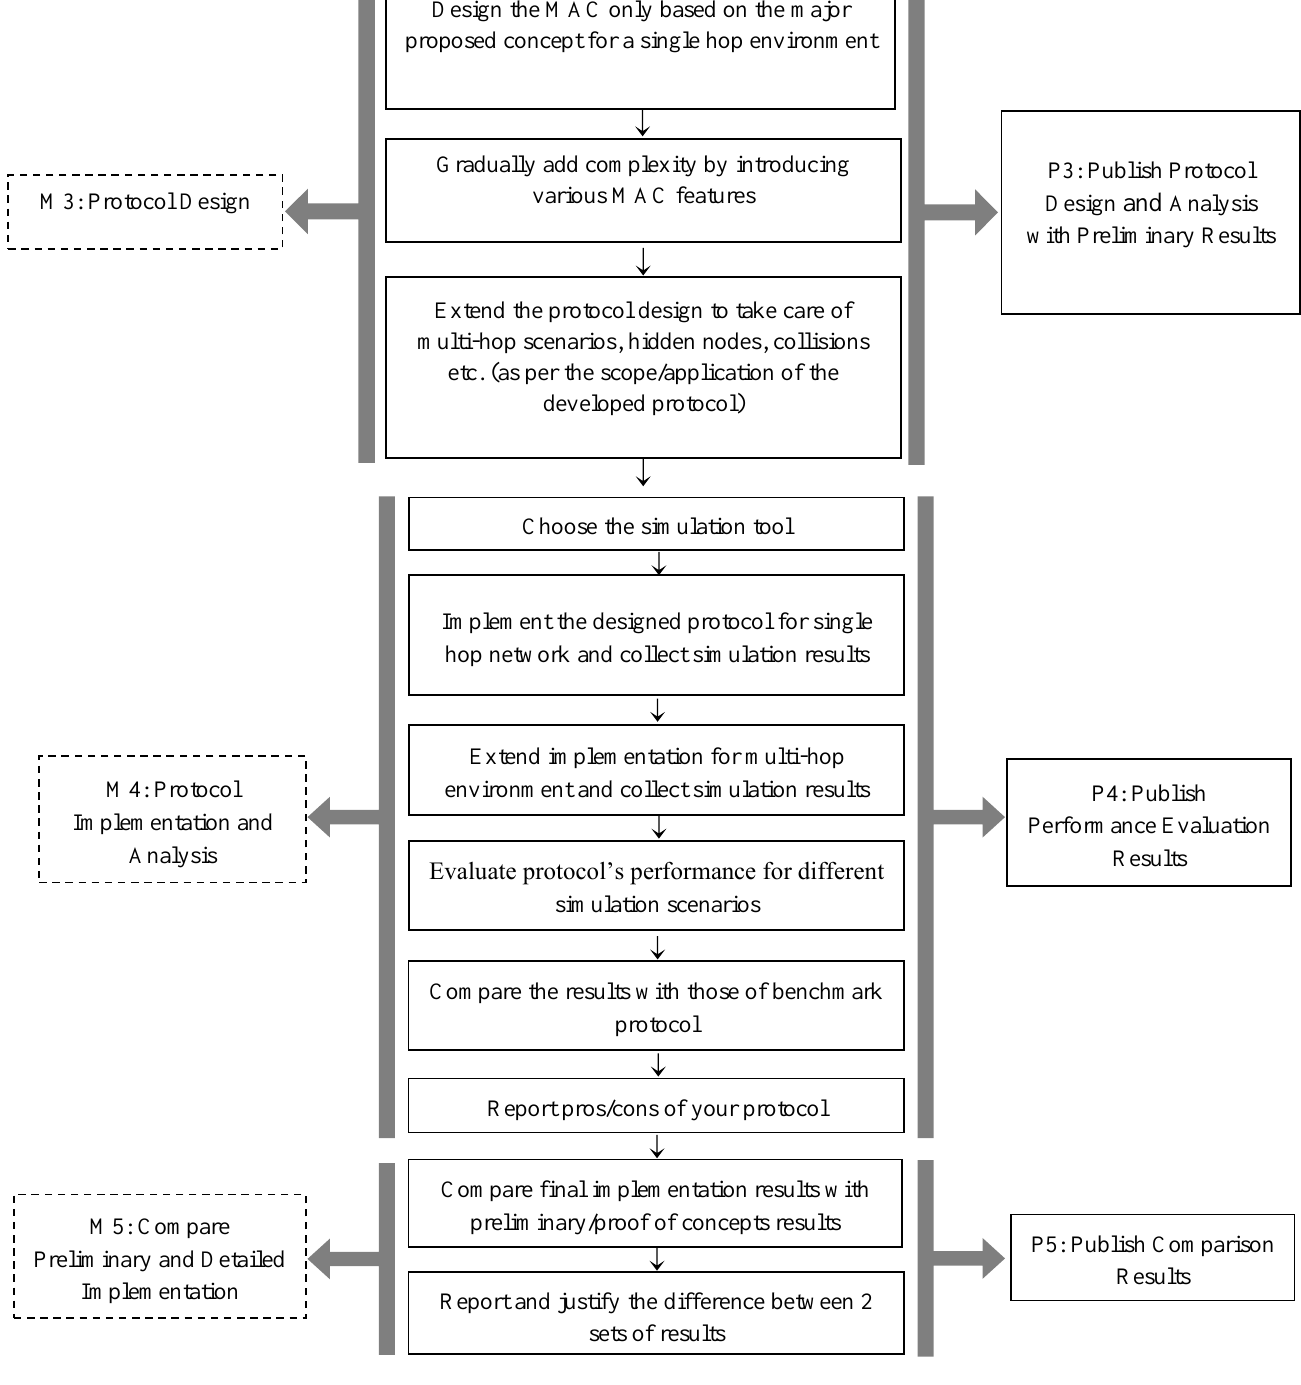
Fig. 1 . Milestones for developing a MAC protocol for